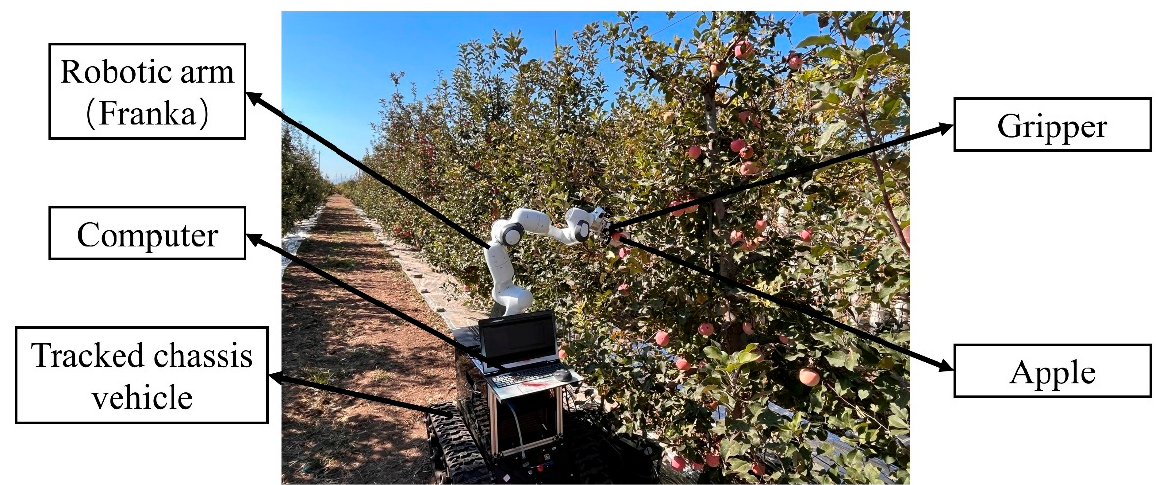
Figure 23. Experimental scene in the orchard.